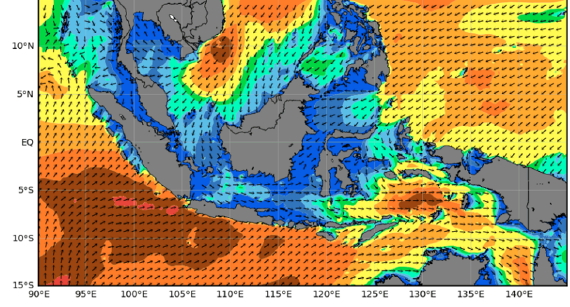
Fig. 2 Ocean surface currents (Source: